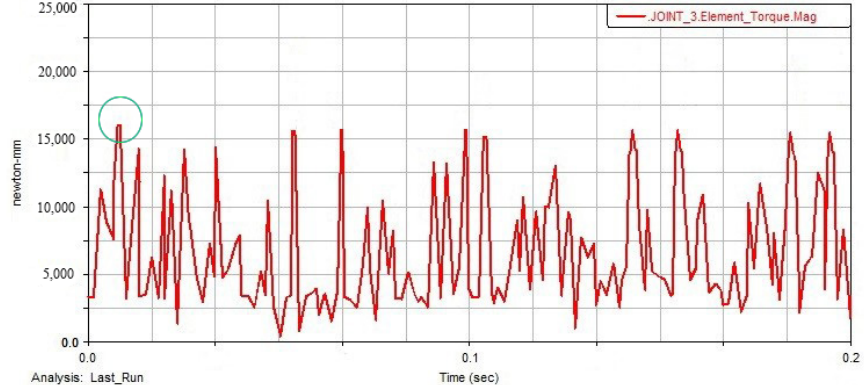
Figure 9. Comparison of spindle torque before stator optimization.